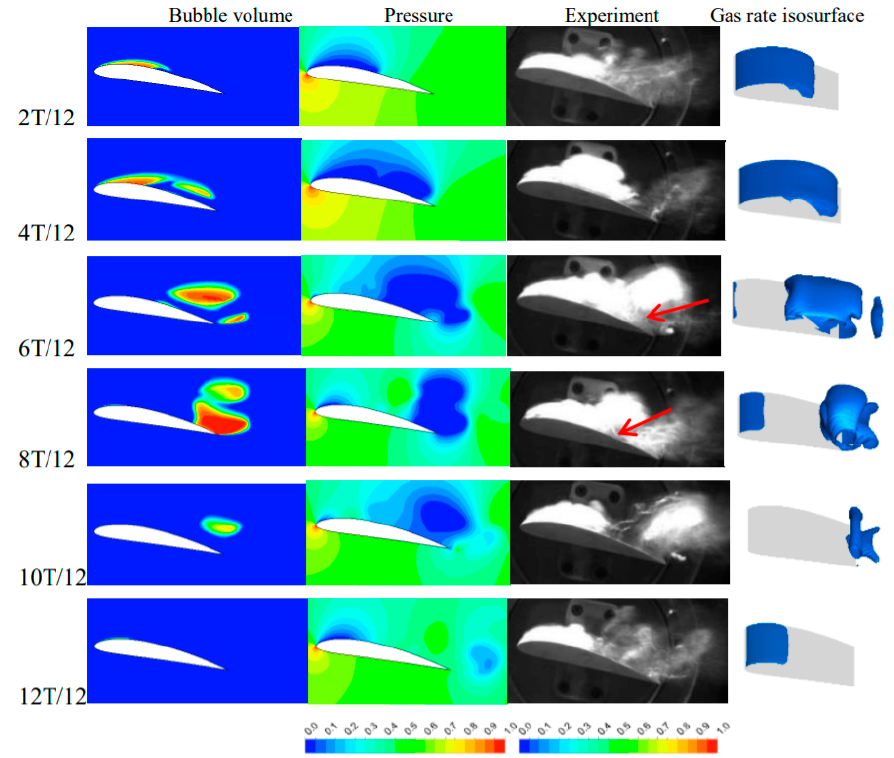
◦ attack angle hydrofoil (gas rate isosurface α